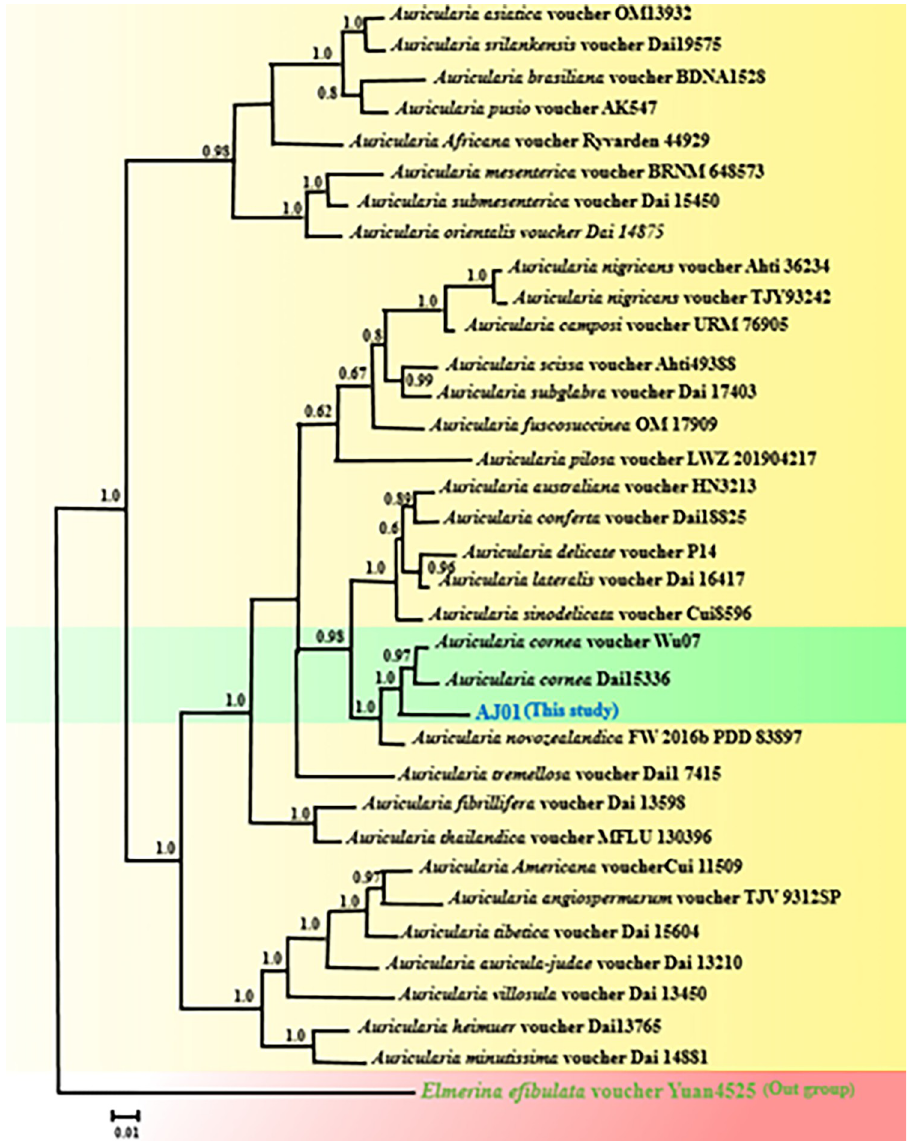
Fig 2. Bayesian tree illustrating the phylogeny of Auricularia species under GTR + G + I model based on the combined sequences of ITS1-5.8S-ITS2 region and RPB2 gene for Auricularia cornea (AJ01) in this study (bold font in the green area) and related species of this genus (in the yellow area), Elmerina efibulata voucher Yuan4525 was considered as outgroup. The sequences were aligned using MAFFT software and edited using Gblocks program. Bayesian posterior probabilities higher than 0.50 are given for appropriate